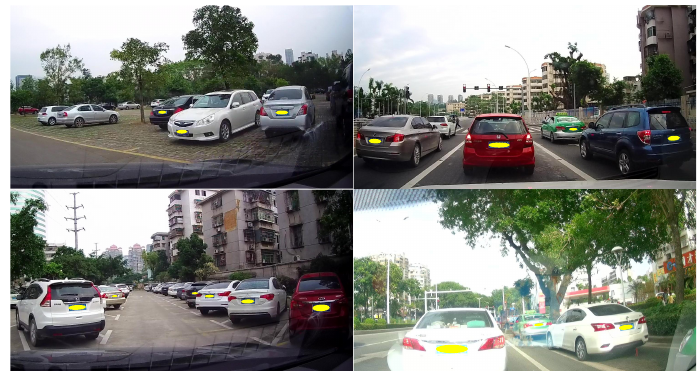
Figure 1. License plates with various sizes, orientations, and backgrounds in real scenarios. All the recognizable license plates are manually covered with a yellow ellipsoid to protect